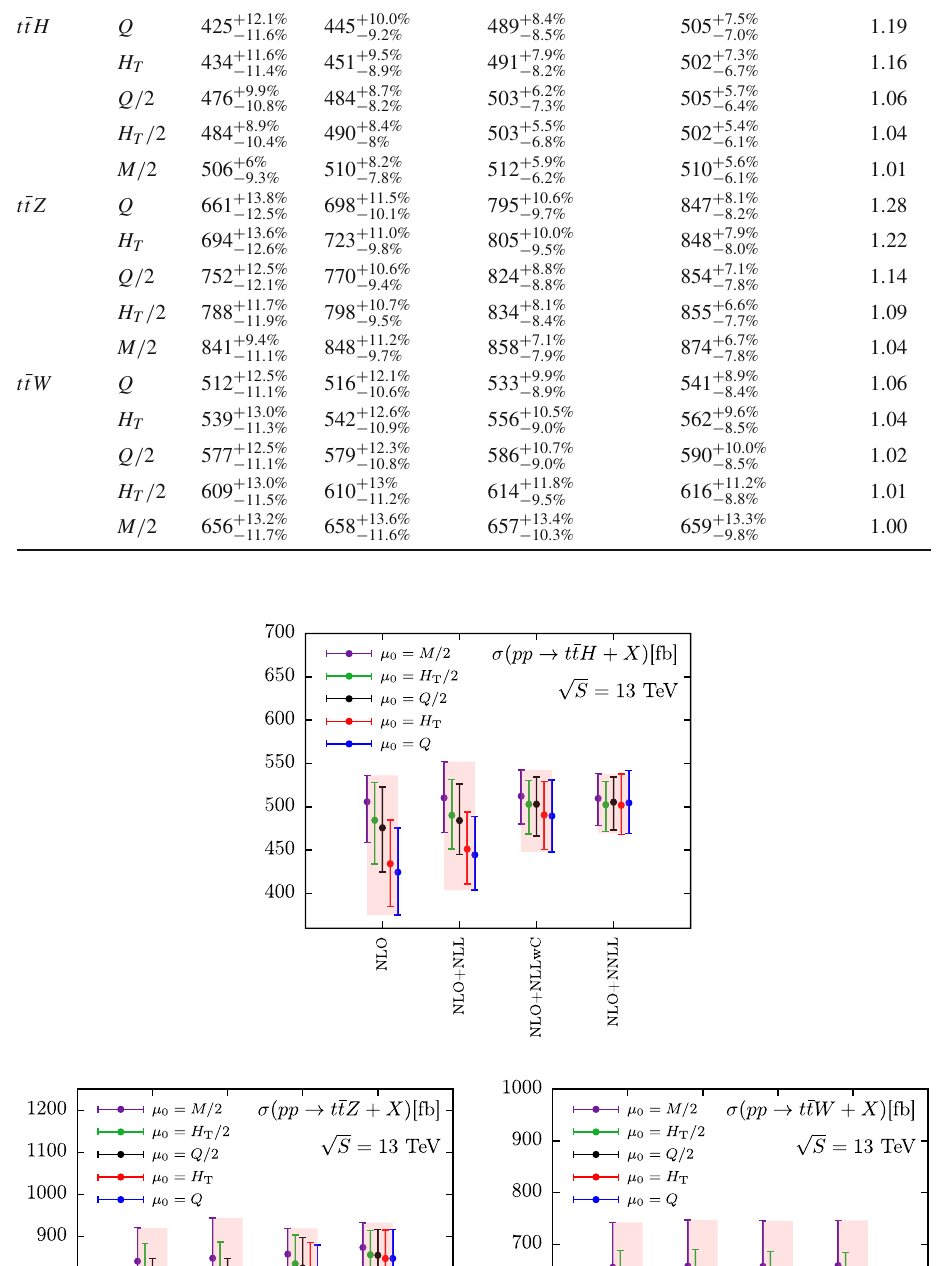
Table 1 Predictions for the total pp → t ¯ t H / Z / W cross √ S = 13 TeV and section at different μ 0 . “NLO” stands here for NLO(QCD + EW). The listed error is the scale uncertainty calculated with the